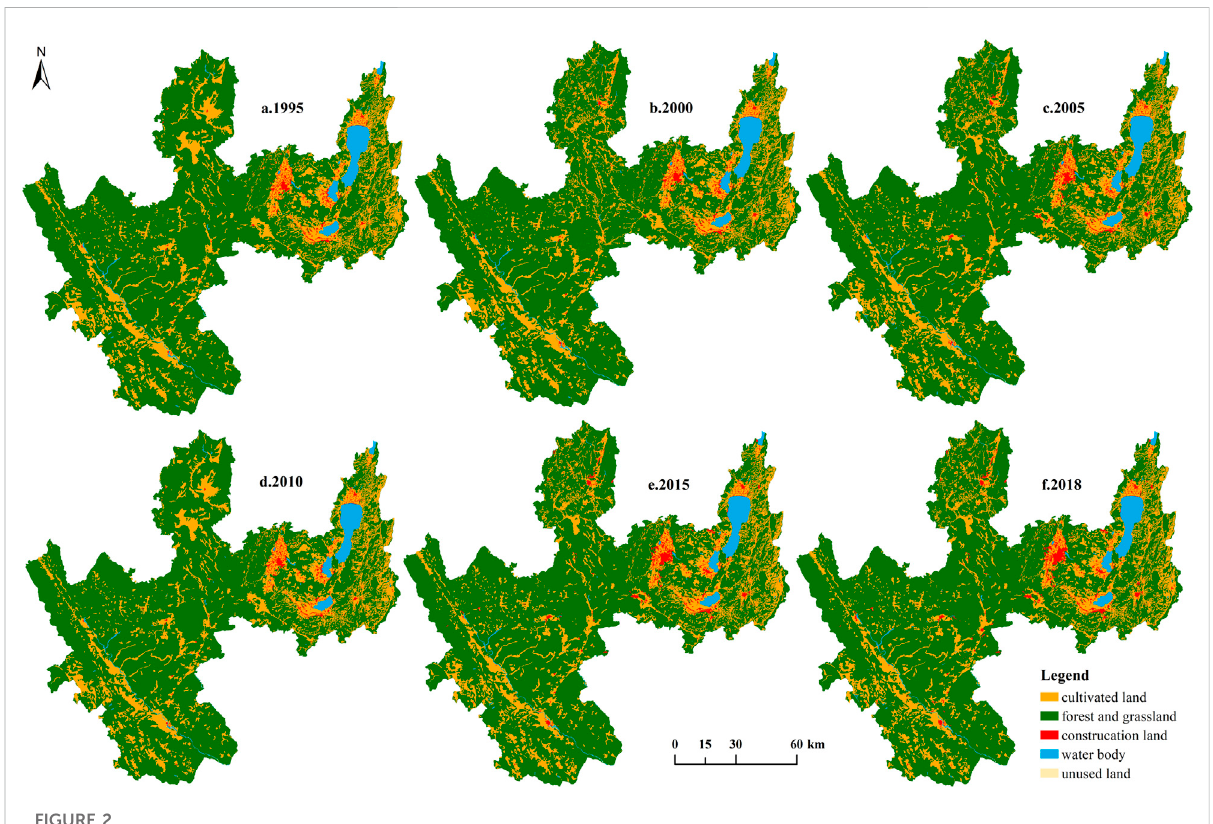
FIGURE 2 Interpretation of land use type in Yuxi City from 1995 to